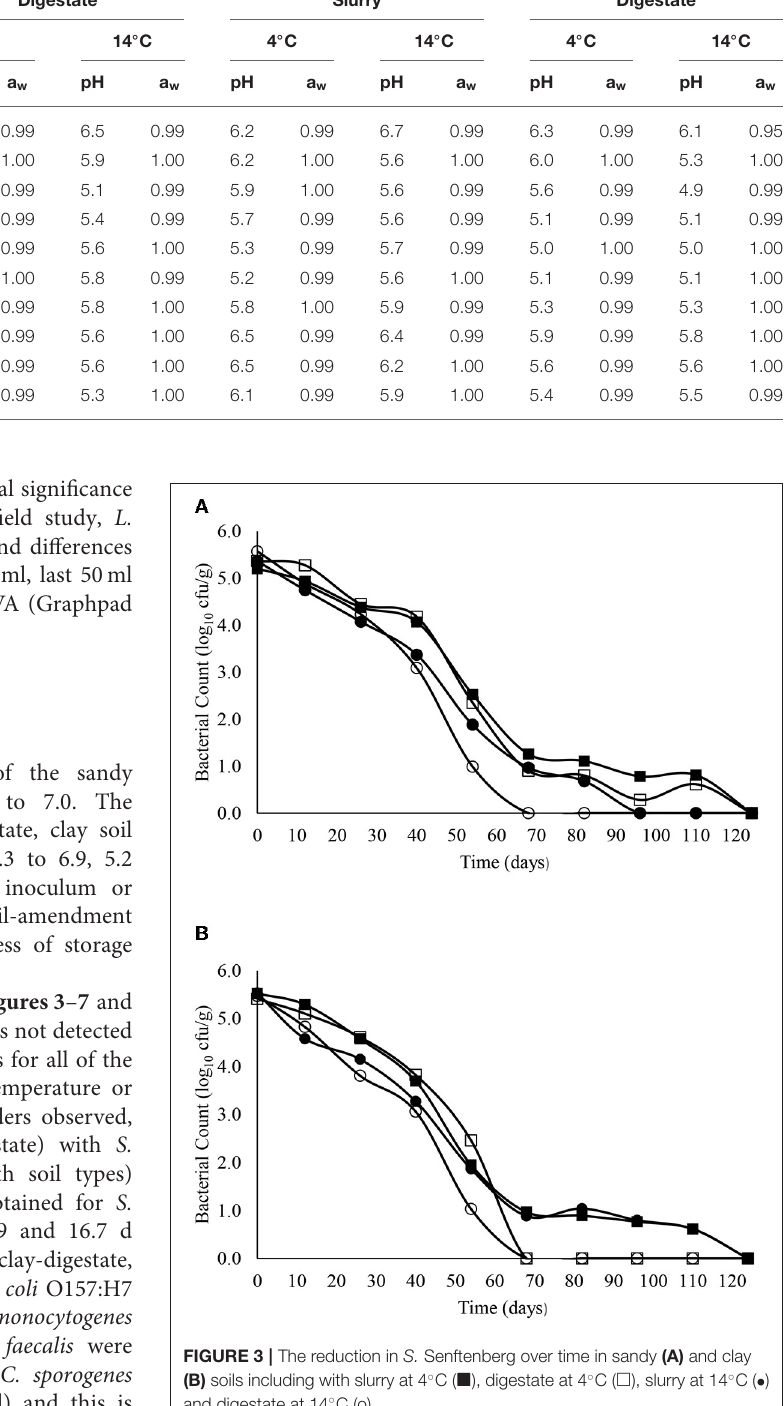
TABLE 1 | The pH and a w of the soil samples throughout the experiment. Time (d) Sandy soil Clay soil Slurry Digestate Slurry Digestate